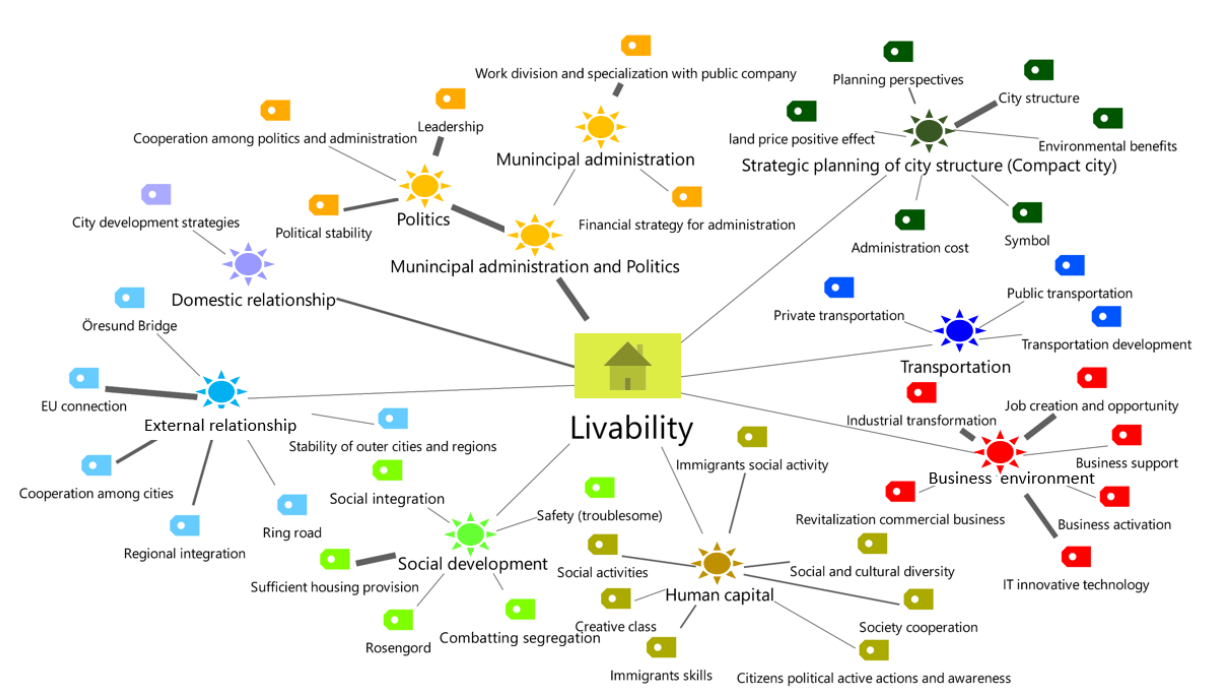
Figure 3. Visualization of context-specific livability aspects, resulting from the 2016 Malm¨o case study presented in this